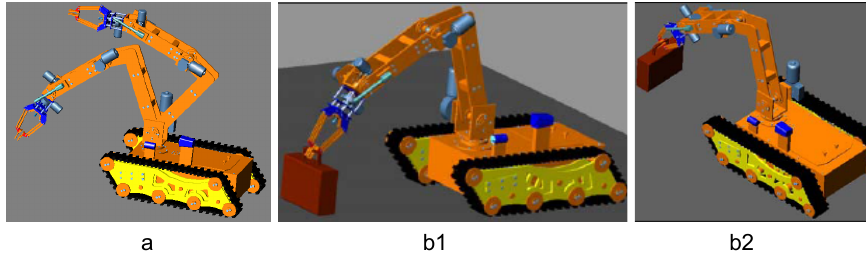
Figure 7 – Functional simulation: without object(a) and with an object(b1,b2) Slika 7 – Simulacija funkcije: bez objekta (a) i s objektom (b1,